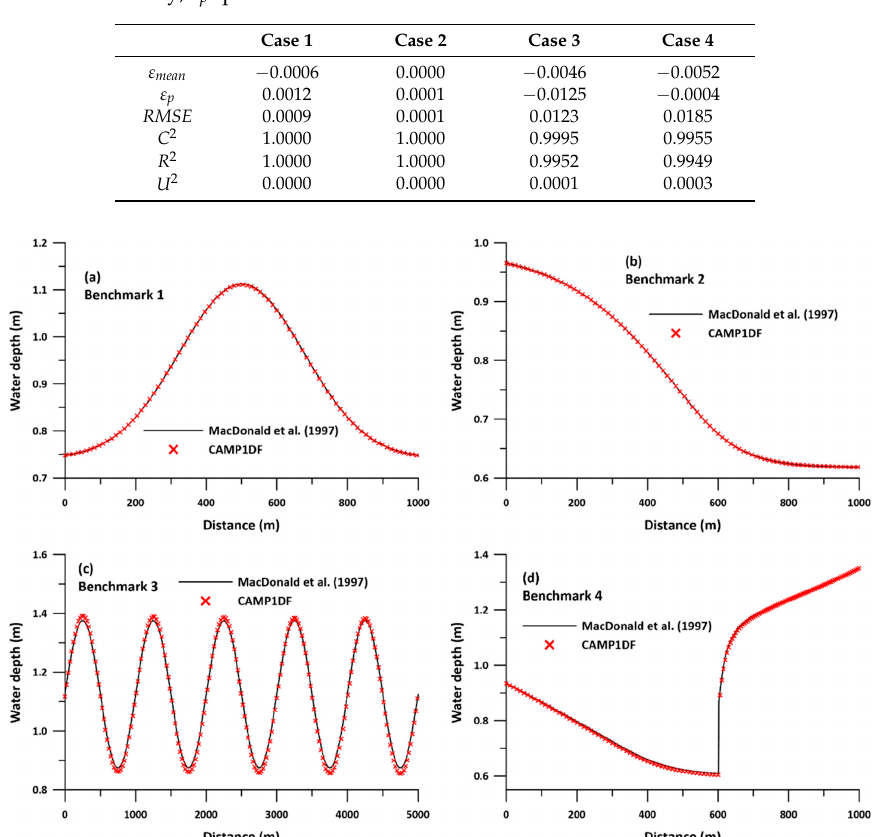
Table 1. Error calculations in the CAMP1DF fully dynamic wave (DYW) simulations of the benchmark problems relative to the analytical results by MacDonald et al. (1997) [30]. RMSE : root mean square error; ε mean : mean error; U 2 : Theil’s prediction/inequality coefficient; C 2 : Pearson´s coefficient; R 2 : Nash–Sutcliffe efficiency; ε p : peak error.